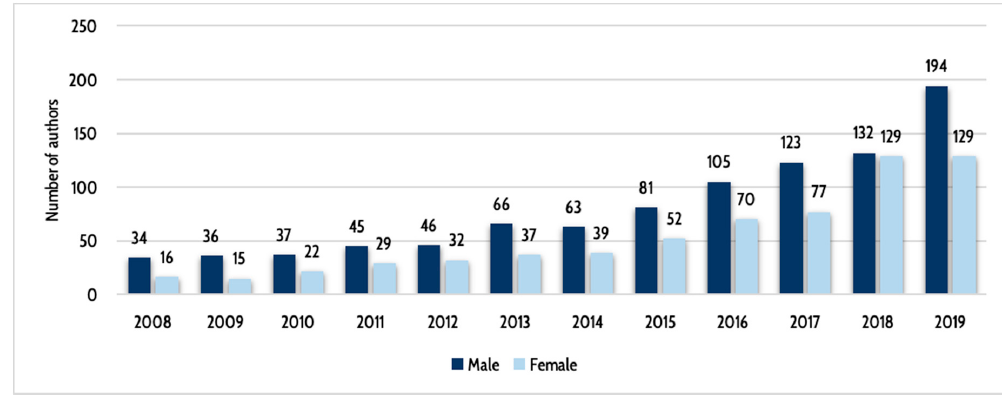
Figure 2. Number of Vietnamese lead authors by gender from 2008–2019 (last updated 30 April 2020).